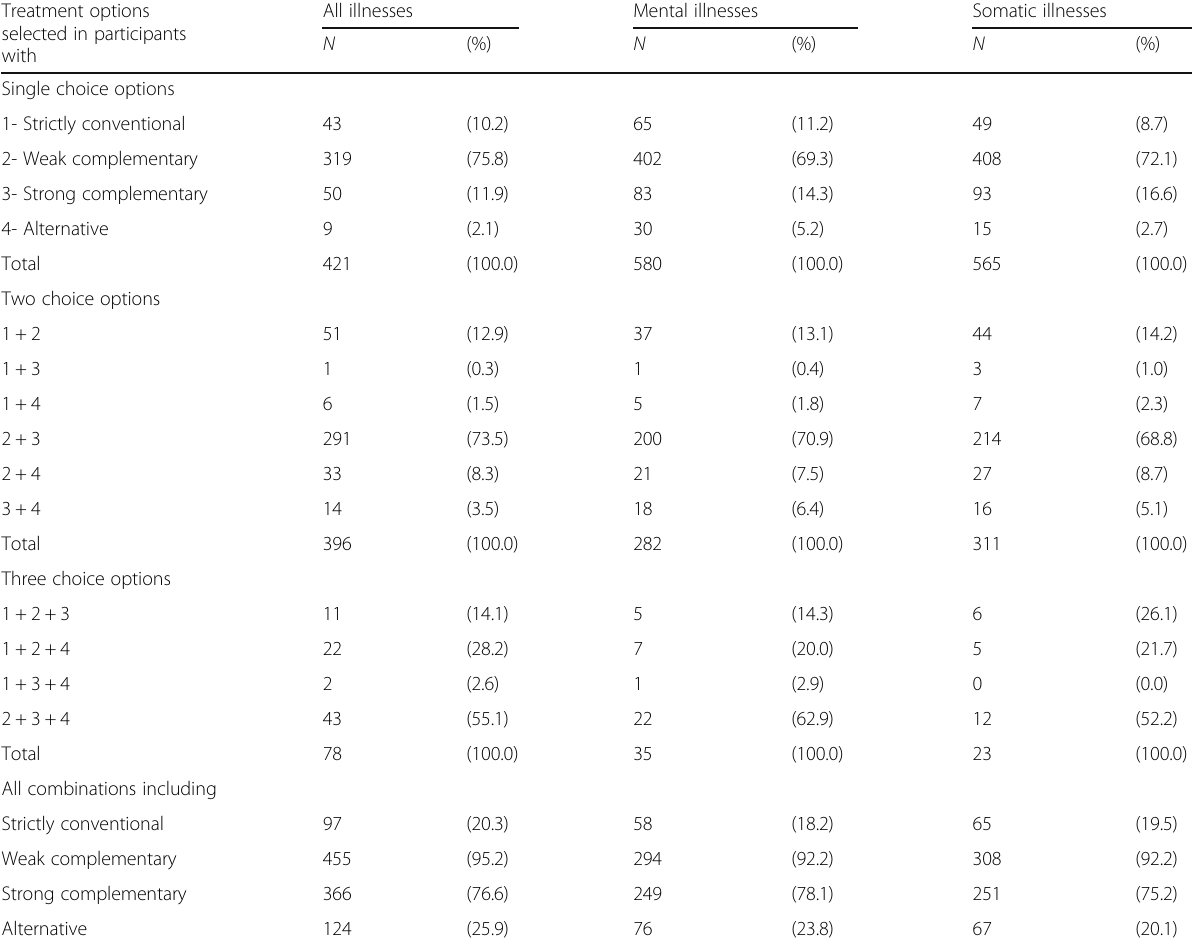
Table 3 Details of the treatment options selected by the participants by type of illness Treatment options selected in participants